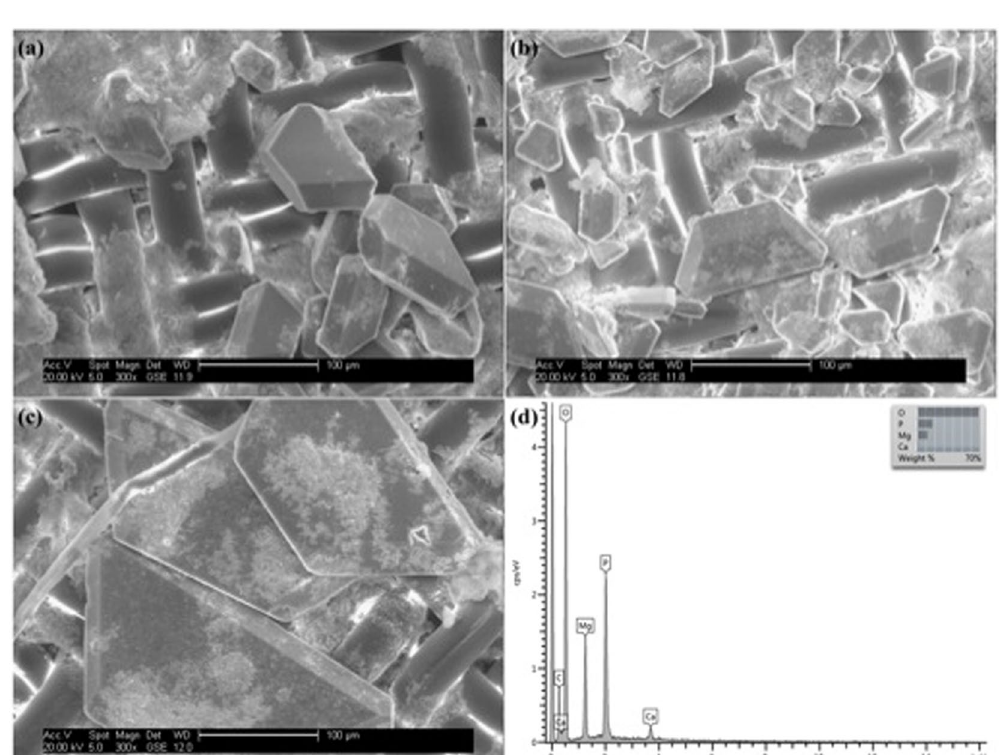
Figure 3. Electron scanning microscope images of the solid precipitate collected at the end of the 10 days of incubation for B. pumilus ( a ), H. salinarum ( b ), and B. antiquum ( c ) at pH 7.3 in sludge dewatering liquors at 300 × magnification, and ( d ) example of an energy dispersive x-ray (EDX) microanalysis of the crystals for B. antiquum ( c ) with weight percentage of the elemental components of the analysed crystal that allowed the identification of the crystal as bio-struvite. EDX was also completed for the crystals produced by B. pumilus ( a ), H. salinarum ( b ) and present overlapping results to figure ( d